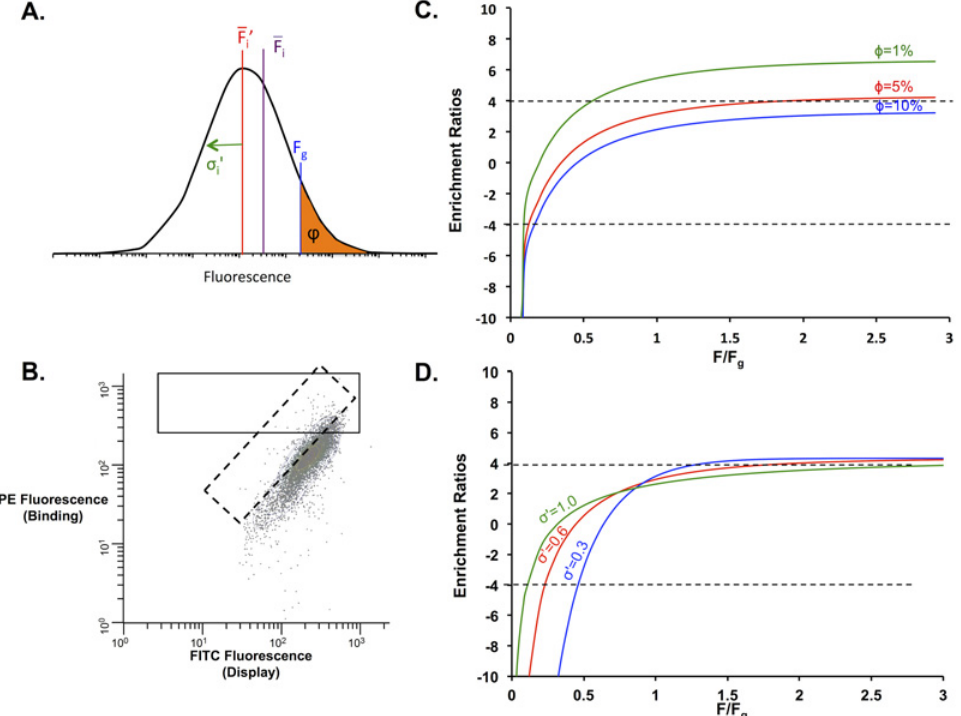
Fig 5. FACS Selection Parameters. A . Individual fluorescence from a clonal population of cells is log-normally distributed with a log-transformed standard (cid:2) (cid:2) 0 and mean fluorescence F deviation σ ´, log-transformed mean fluorescence F . Cells are collected based on the gating fluorescence, F g , which controls the i i fraction of cells collected, φ . B . Sample FACS readout for yeast-surface display. The x-axis represents the fluorescence of the displayed population, whereas the y-axis represents the fluorescence of the binding activity of interest. Both square (solid line) and diagonal (dashed line) gates can be drawn around the population to be sorted. Diagonal gates will decrease the standard deviation of the transformed fluorescence distribution, narrowing the range of protein activities that can be resolved. C . The enrichment values as a function of the ratio of the individual fluorescence to the gating fluorescence for different gating percentages (1%, green; 5%, red; 10%, blue) for σ ´ = 0.6. In more stringent sorts, resolution is lost in the enrichment ratios for poor binders. The dynamic range for the fraction of cells collected is between 5 and 10%. D . The enrichment values as a function of the ratio of the individual fluorescence to the gating fluorescence for different standard deviations (1.0, green; 0.6, red; 0.3, blue) for a gating percentage of 5%. Setting smaller standard deviations by two-color sorting using diagonal gates narrows the dynamic range of enrichment values for the sorted